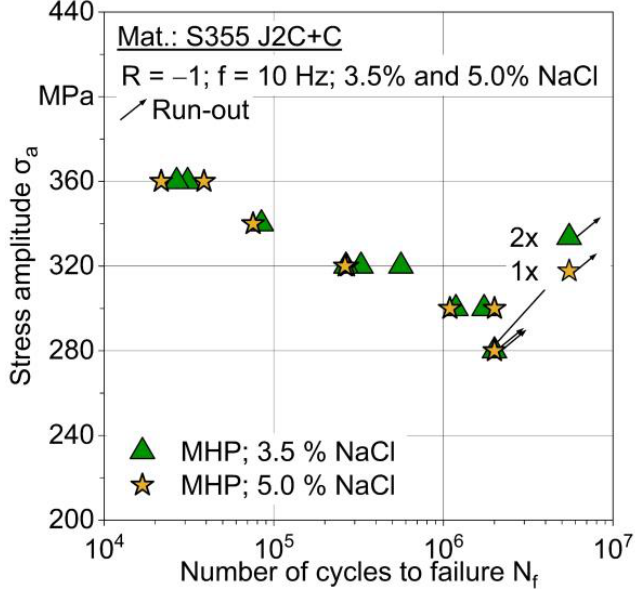
Figure 12. S-N diagram for 3.5% and 5.0% NaCl solution for specimen condition: Machine hammer- peened (III).